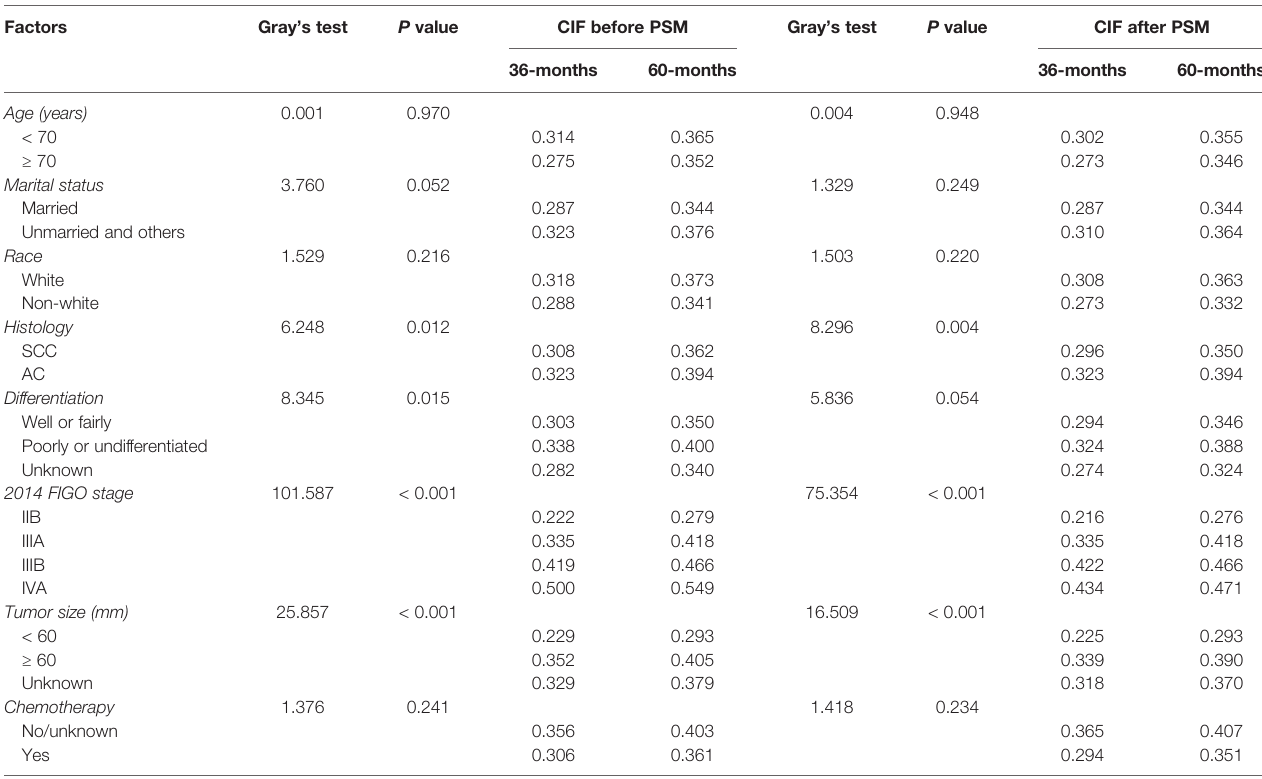
TABLE 2 | Univariate analysis of OS using a competing risk model in patients with stage IIB-IVA CC who received EBRT and BRT before and after PSM.